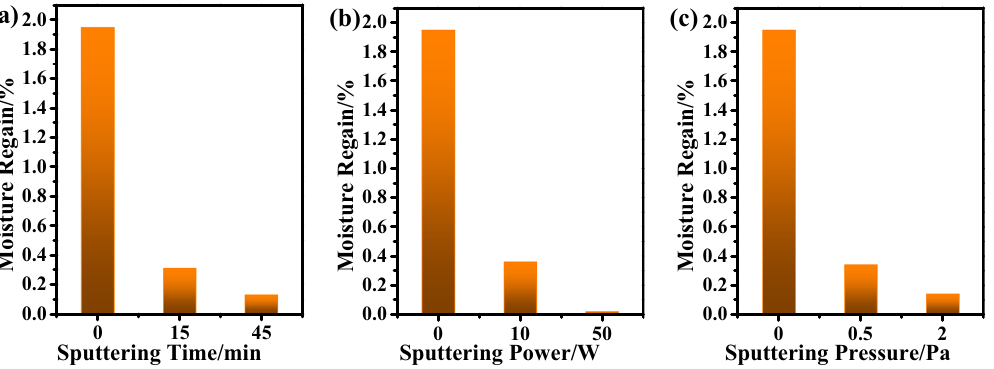
Figure 8: E ff ects of technological parameters: ( a ) sputtering time, ( b ) sputtering power, and ( c ) sputtering pressure on the moisture regain property of PP fi bers.